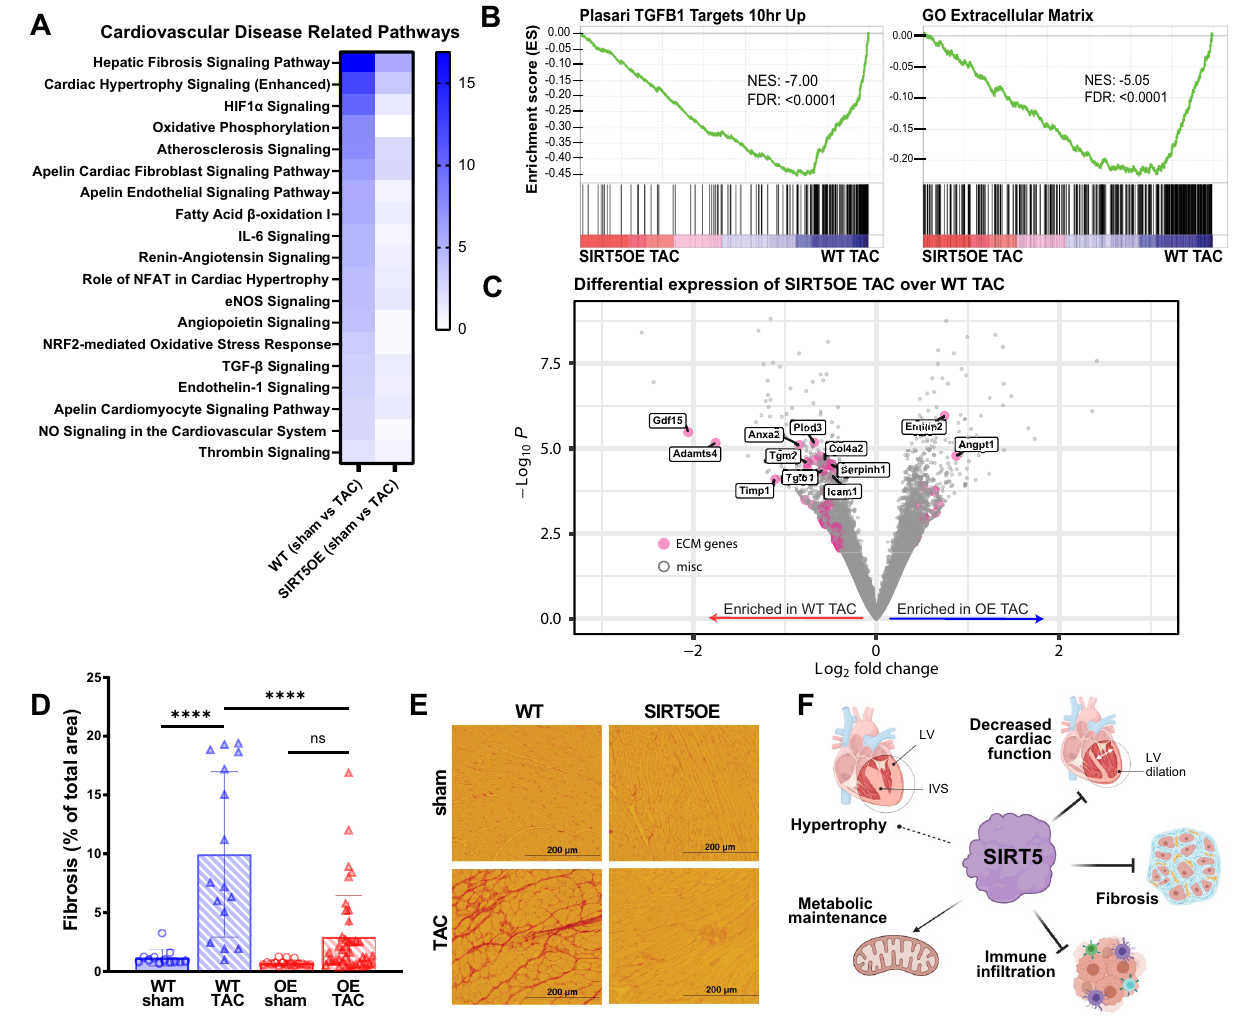
Figure 6. SIRT5OE protects against TAC-induced fibrosis four weeks after surgery. (A) Heat map of gene ontology analysis of WT (sham vs TAC) and SIRT5OE (sham vs TAC) mapping to cardiovascular disease related pathways using IPA. Blue color scale represents -log(p-value) of each pathway. (B) GSEA of SIRT5OE TAC compared to WT TAC RNA-seq samples. NES: normalized enrichment score. FDR: false discovery rate. (C) Volcano plot highlighting significant genes in from the GO: collagen containing extracellular matrix gene list. (D) Quantification of the amount of fibrosis in each heart sample, expressed in percentage [WT sham ( n = 3), WT TAC ( n = 4), SIRT5OE sham ( n = 4) and SIRT5OE TAC ( n = 10)]. Two-way ANOVA interaction term: p-value = 0.0012. (E) Representative images of heart sections stained with Picrosirius red for collagen. (F) Summary figure of effects of SIRT5 overexpression during pressure